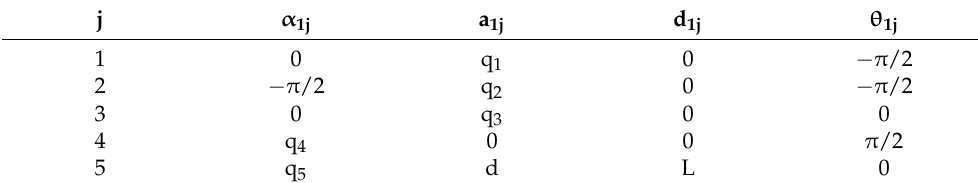
Table 1. Denavit–Hartenberg (DH) parameters of the Table 1. Denavit – Hartenberg (DH) parameters of the robot.